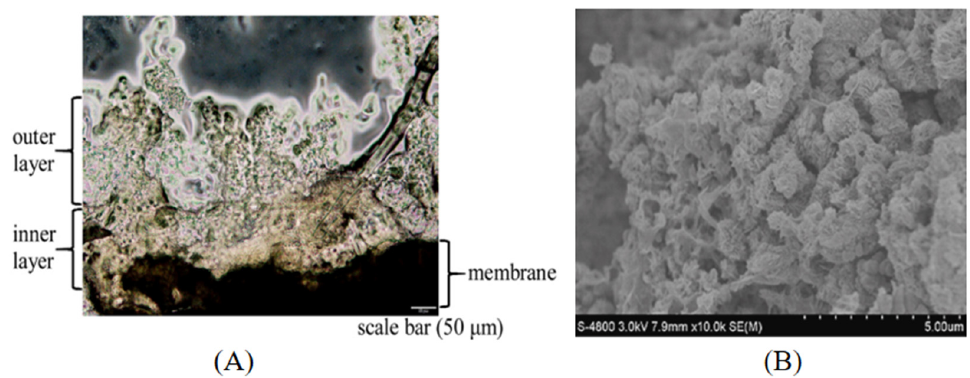
Figure 5. The biofilm morphology observed by different methods, ( A ) microscope [76], ( B ) scanning electron microscope [71]. electron microscope